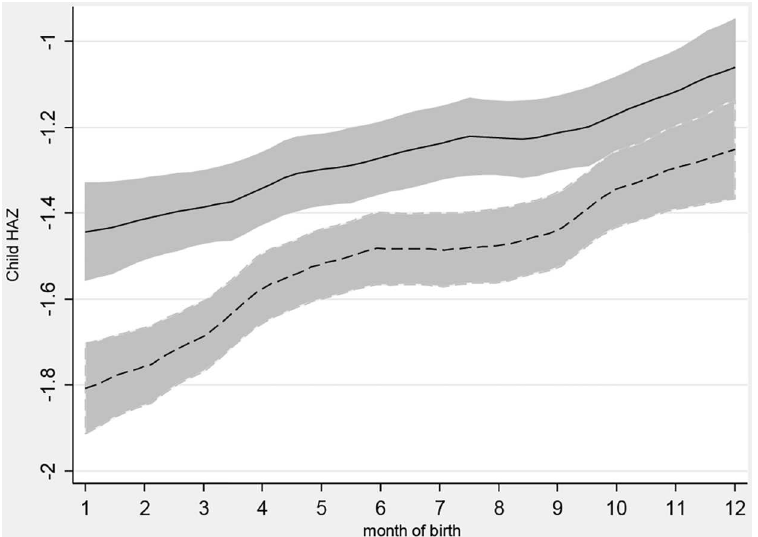
Fig 3. HAZ by month of birth and household remoteness. Notes: A local polynomial smoothingregression of child heights for births in each month of the year, stratified by place of residenceand the presenceof seasons. Remote with seasons is dashedline. 95% ConfidenceIntervals included. To account for inversionof seasons, birth date is shown by calendarmonth in the southern hemisphere, and for the northern hemisphere is shownas 1 = July, 2 = Aug.